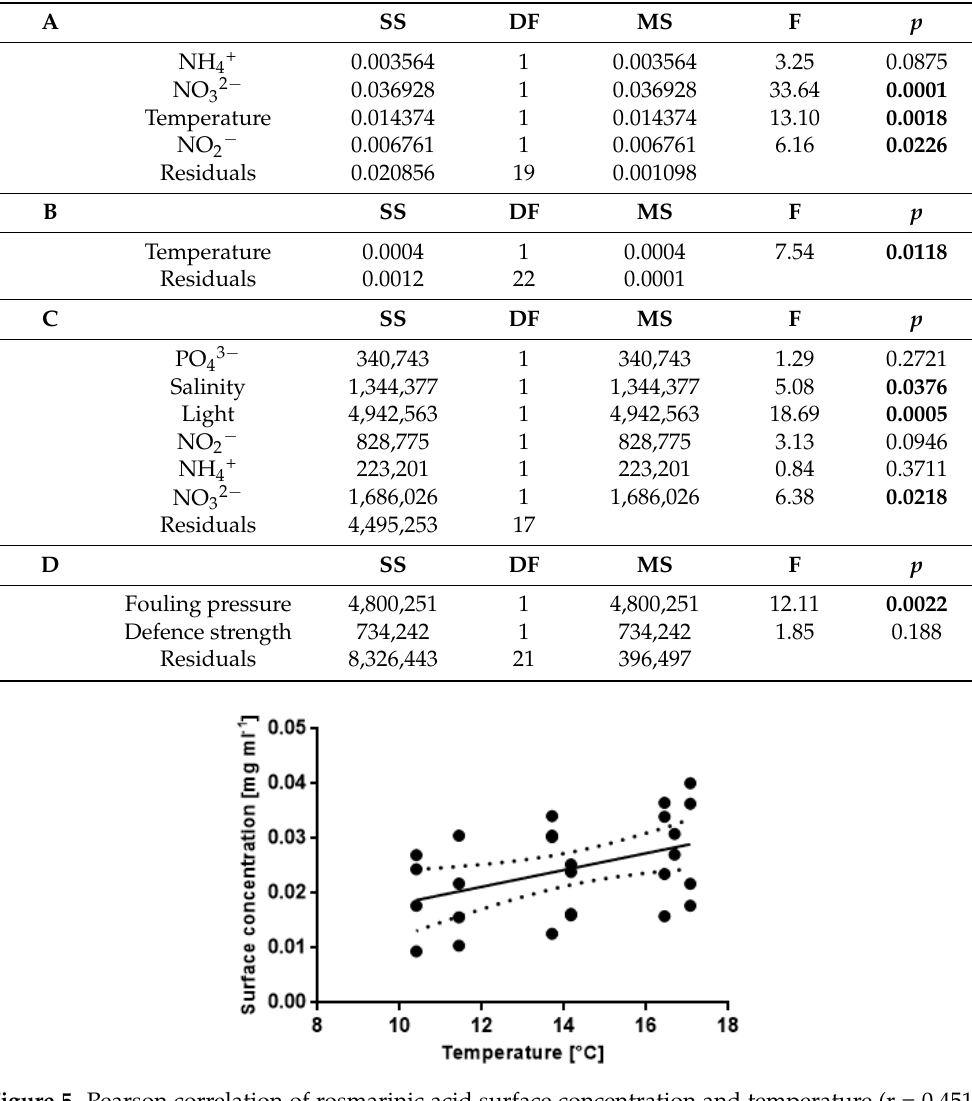
Figure 5. Pearson correlation of rosmarinic acid surface concentration and temperature (r = 0.4513; p = 0.0159; Dotted lines represent the 95% CI).